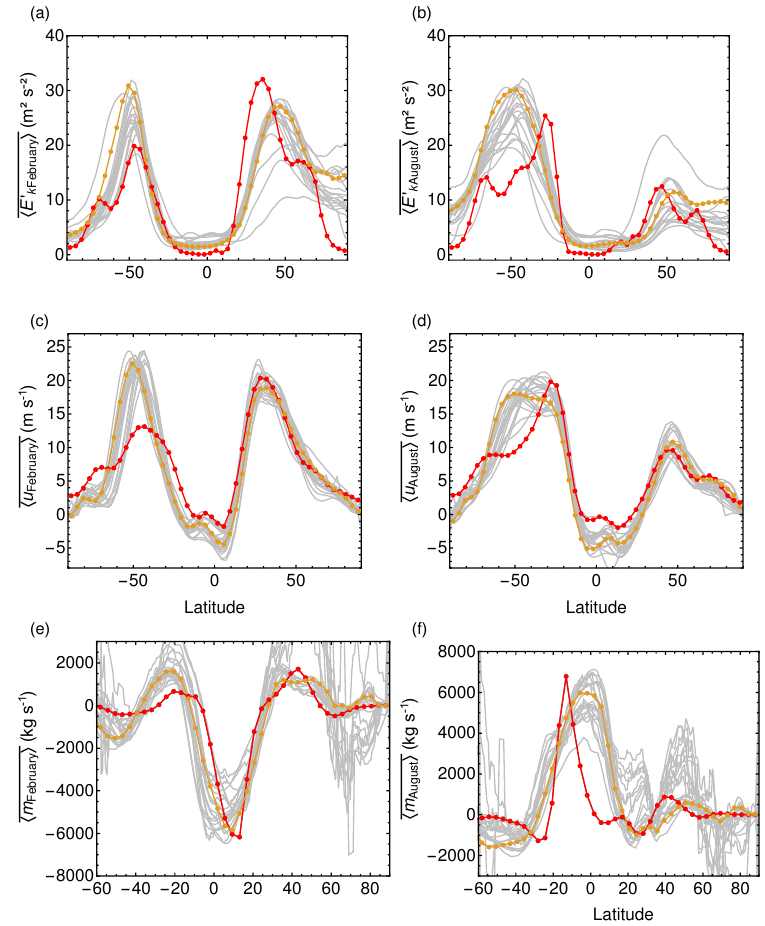
Figure 10. Comparison to CMIP5 models. The orange line represents ERA-Interim data, the red line results from Aeolus and gray lines CMIP5 models (annual mean zonal-mean